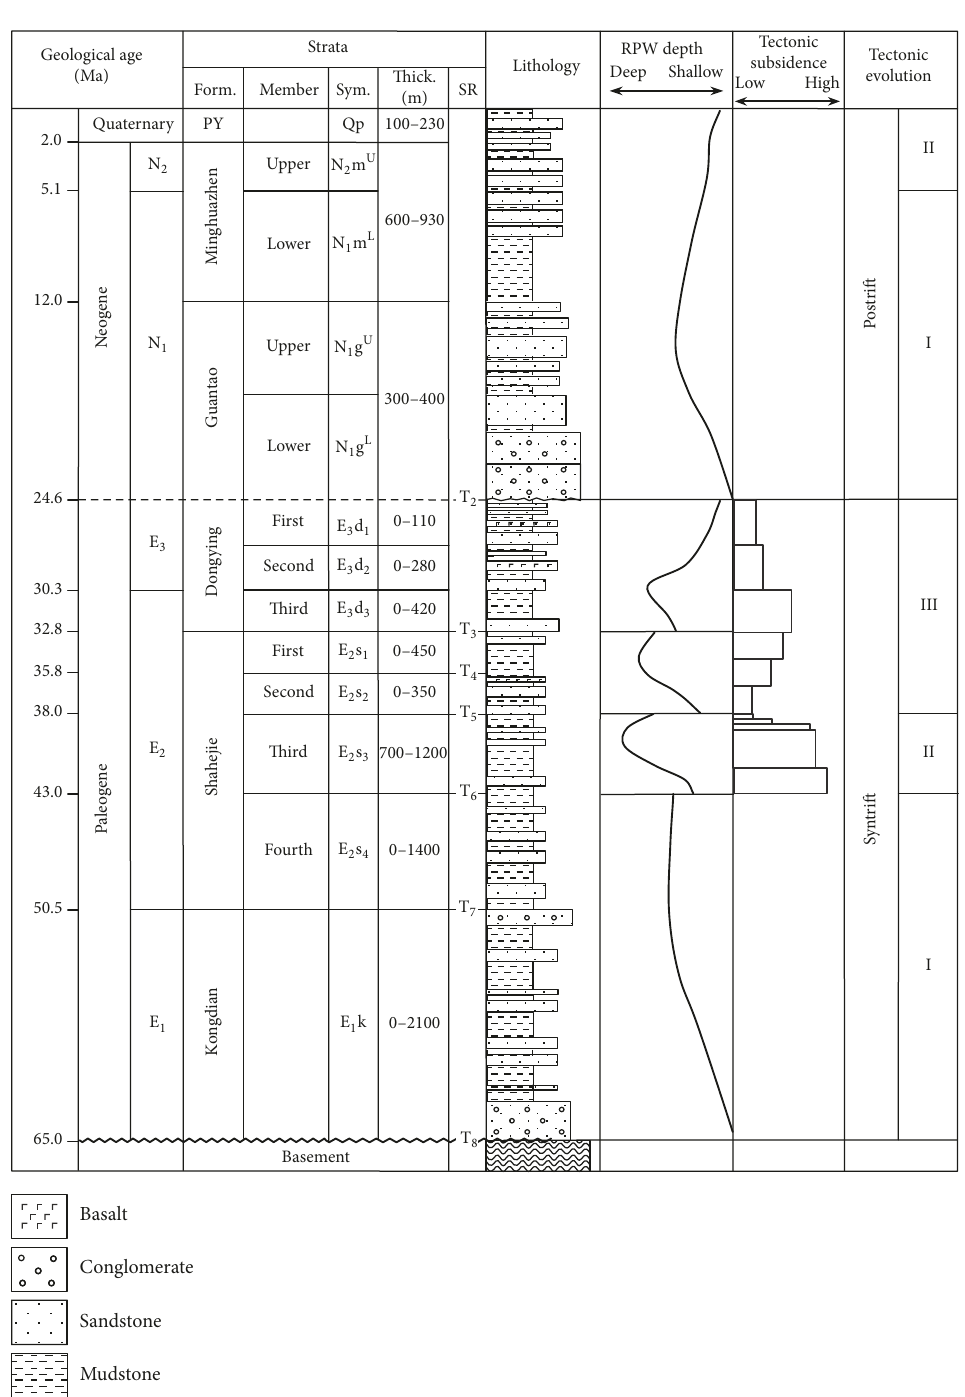
Form. = formation; PY = pingyuan; SR = seismic reference; RPW depth = relative paleowater depth; Sym. = symbol. Figure 2: Generalized stratigraphic column of the Bohai Bay Basin (modified from [8]). Labels I, II, and III in the far right column mark the tectonic substages of the synrift and